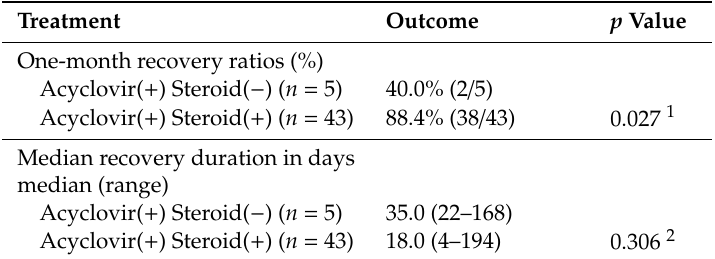
Table 5. Outcome of the facial palsy in patients with herpes zoster